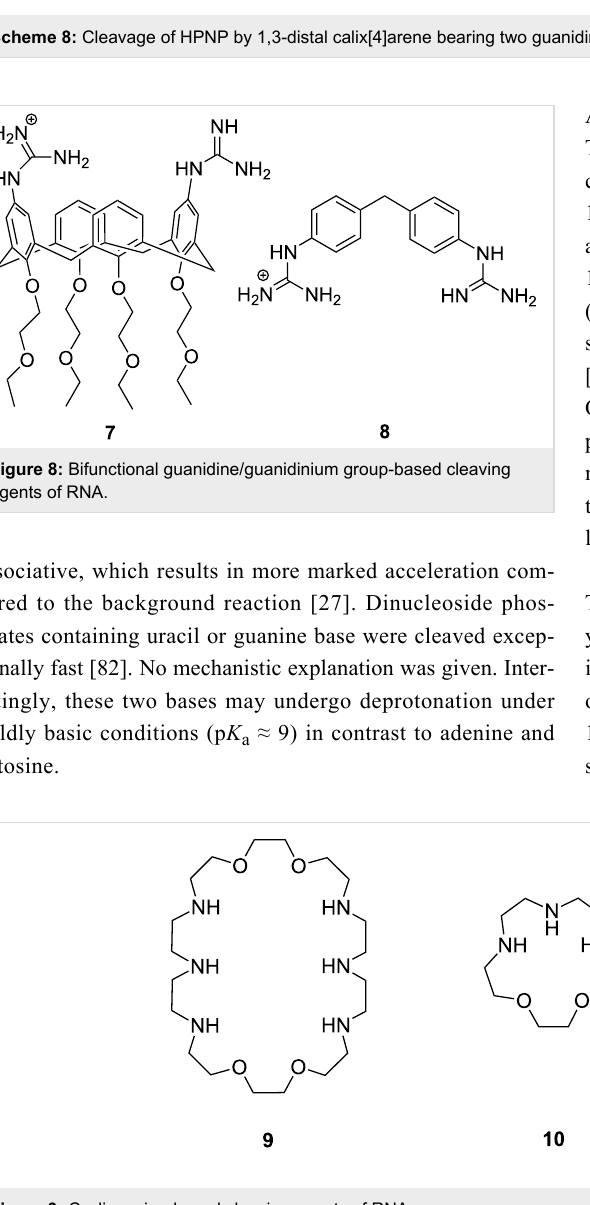
Figure 9: Cyclic amine-based cleaving agents of RNA.